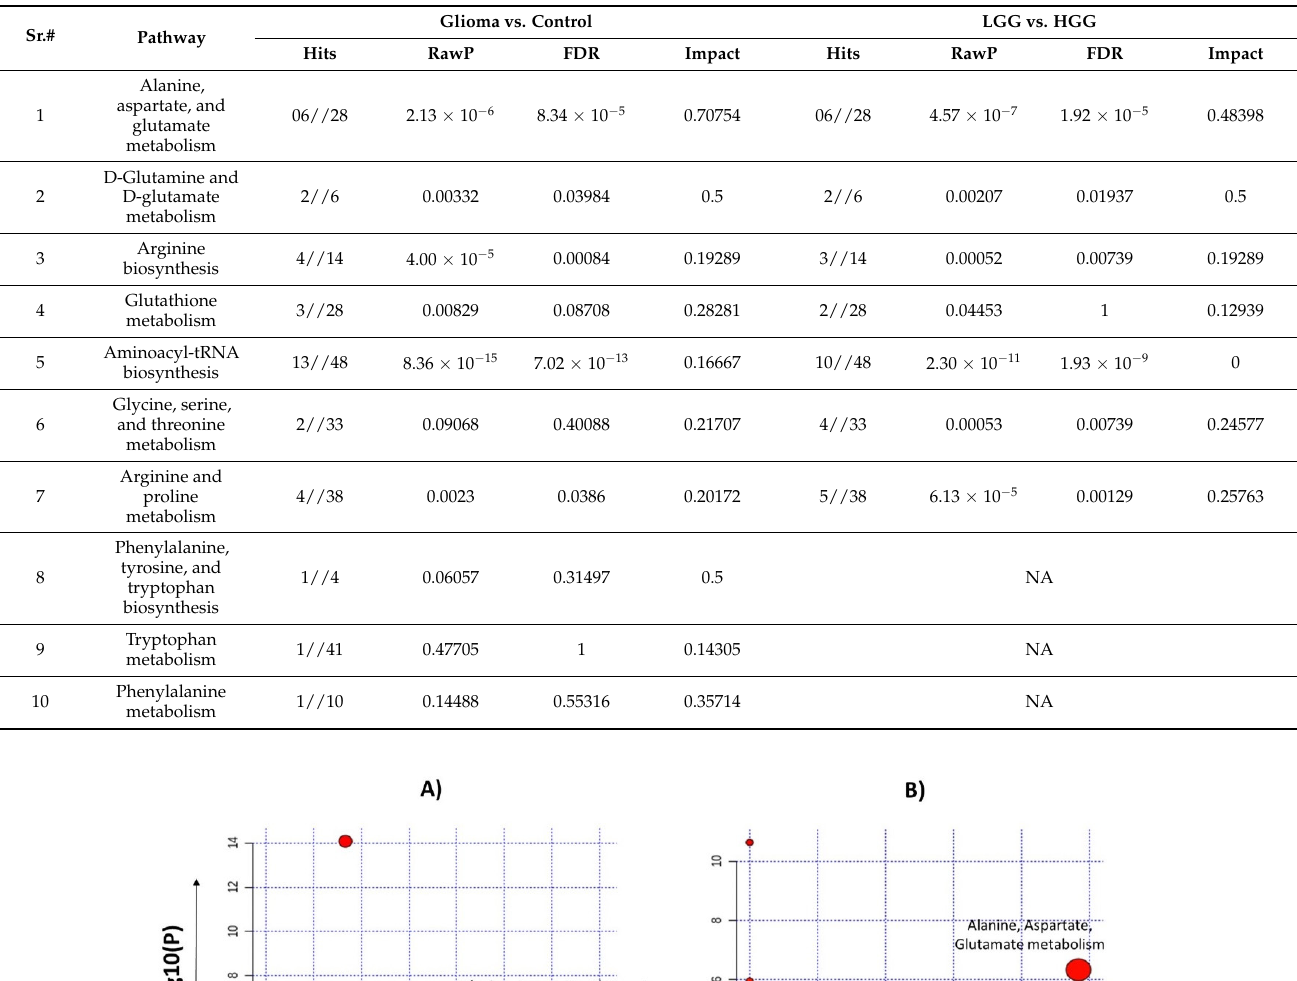
Table 4. List of metabolic pathways dysregulated for two comparison sets.